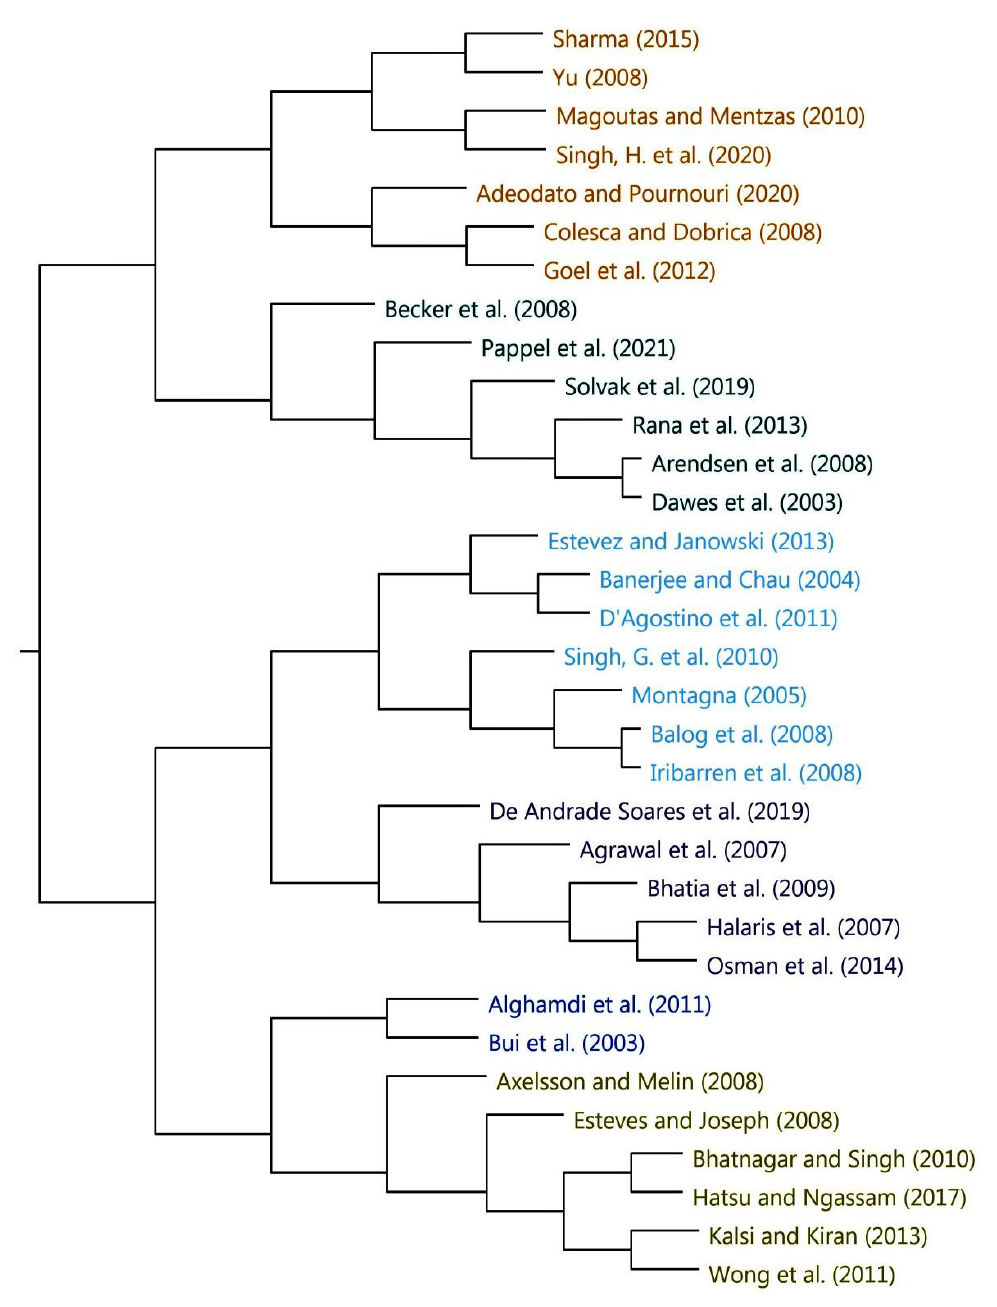
Figure 7: Hierarchical clustering of the selected studies based on